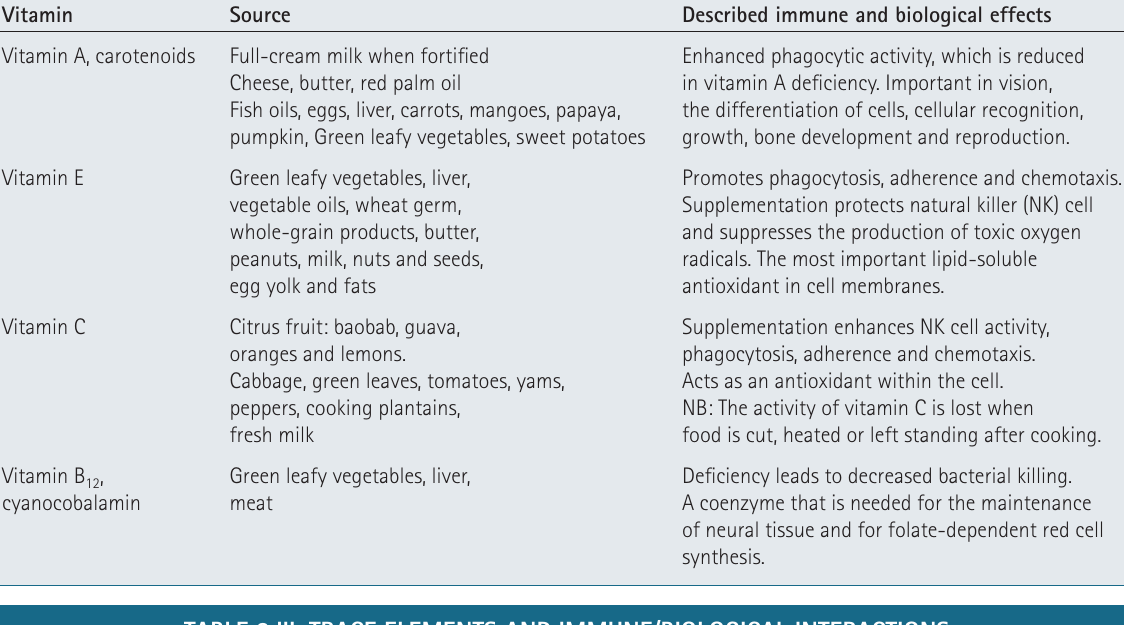
TABle 3.II. VITAMINs AND IMMUNe/BIOlOGICAl INTeRACTIONs